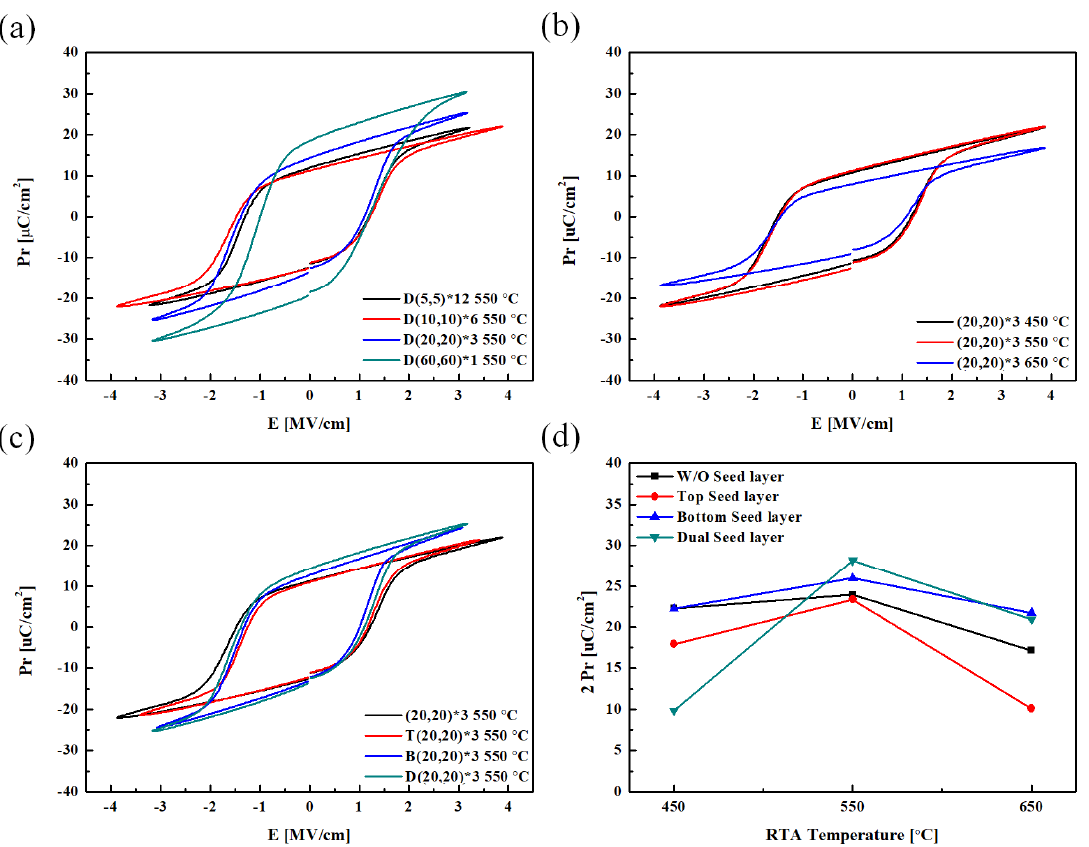
Figure 11. P − E hysteresis curves according to the variables: ( a ) HZO nanolaminate thickness, ( b ) annealing condition, and ( c ) seed layer. ( d ) 2 P r value according to the seed layer and annealing condition.